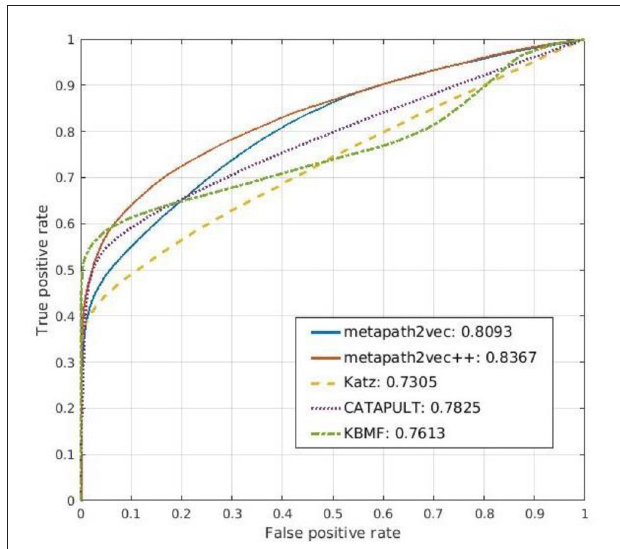
FIGURE 8 | Comparison of the prediction results of metapath2vec and metapath2vec ++ with those of three conventional prediction algorithms, namely, Katz, CATAPULT, and